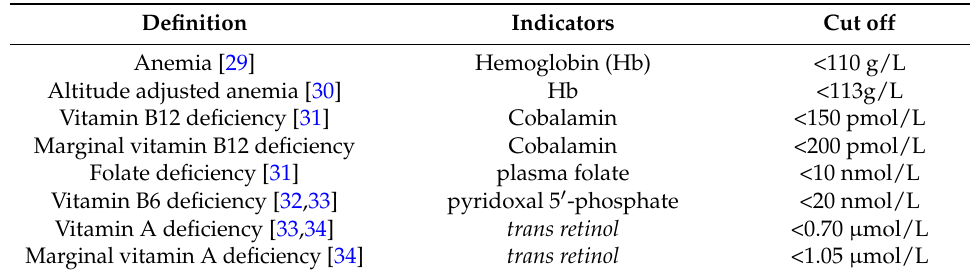
Table 1. Definition and cut-off values of anemia and plasma concentration of vitamin and metabolites among 467 infants in Bhaktapur,